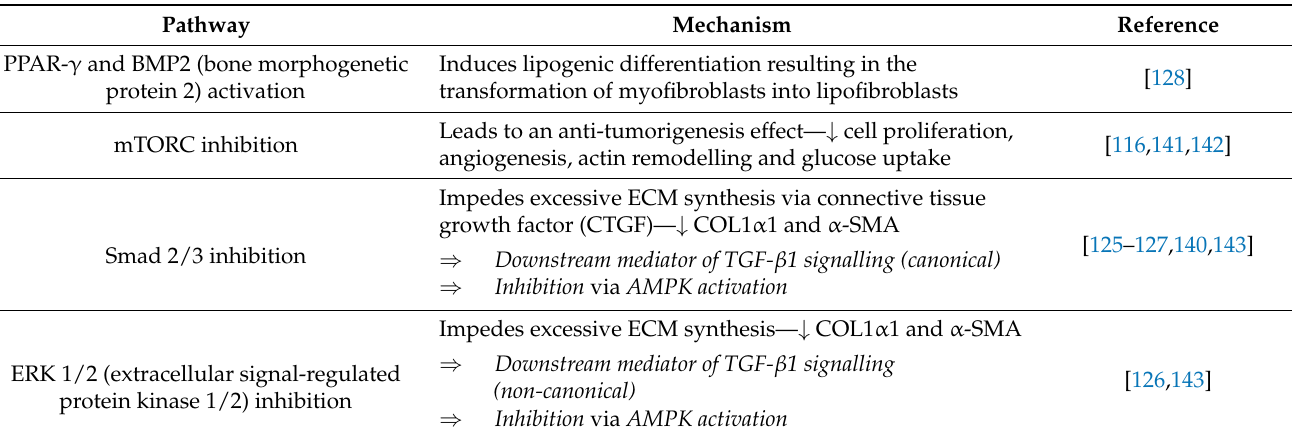
Table 3. Anti-fibrotic signalling pathways of metformin (independent of